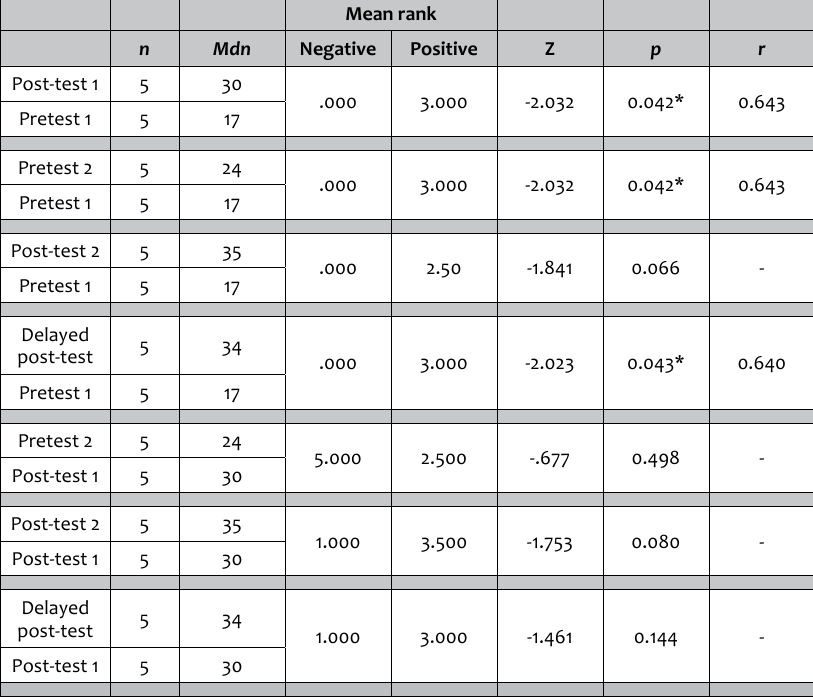
Table 2: Comparison of differences between test results within experimental group A Mean rank n